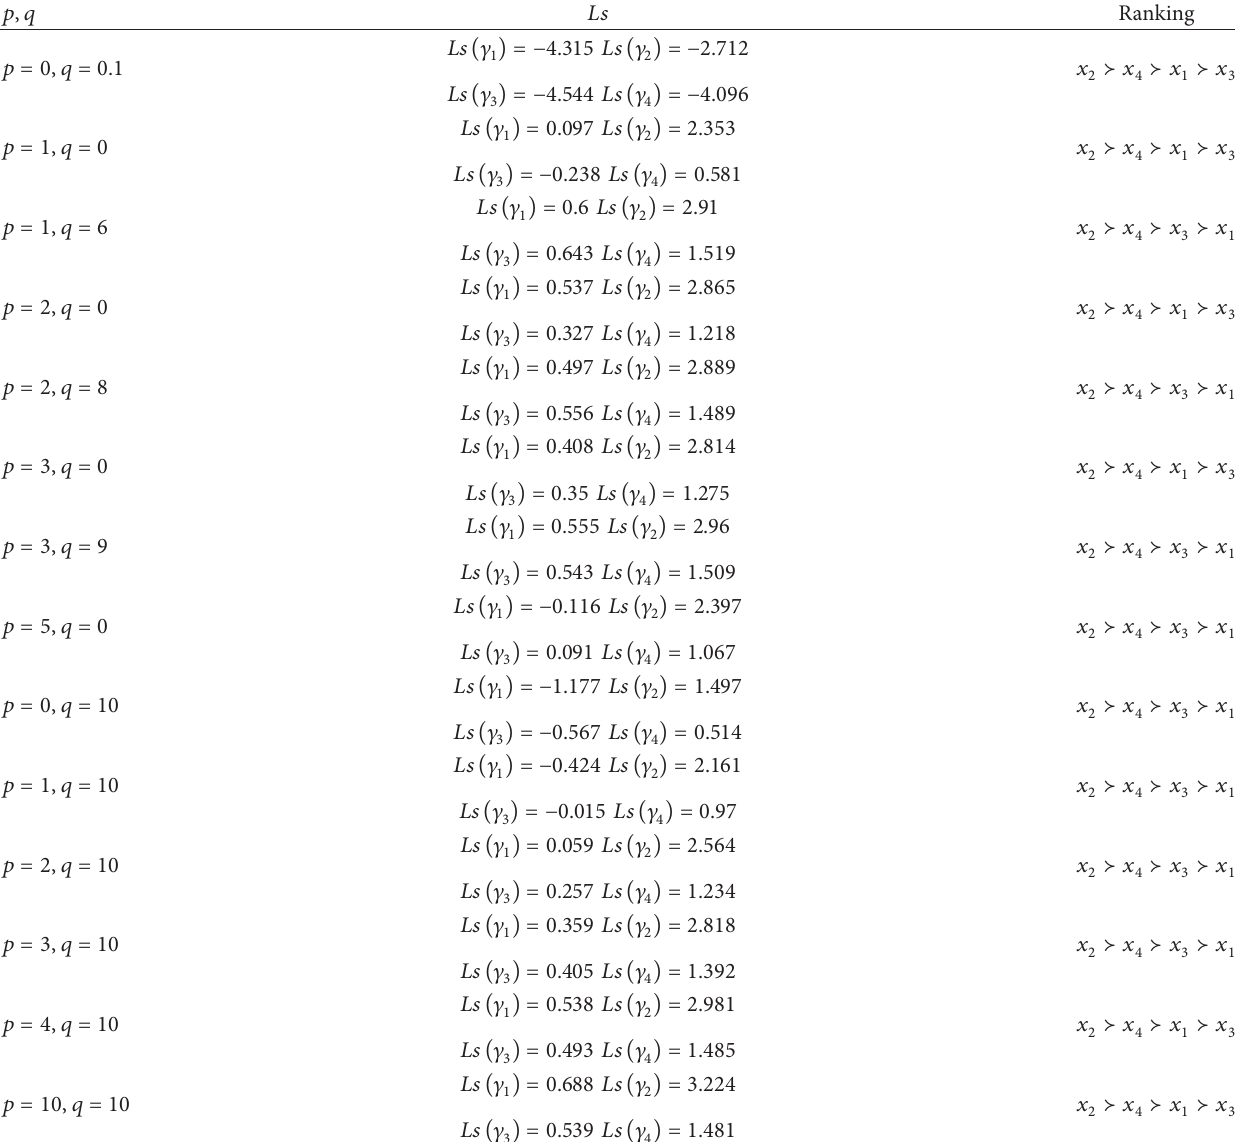
Table 7: Ranking according to different values of 𝑝 , 𝑞